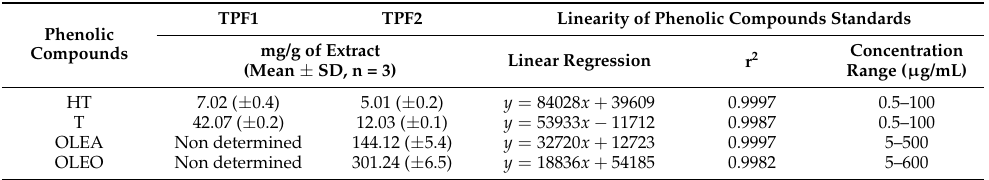
Figure 1. HPLC-DAD chromatograms obtained from the analysis of TPF1 ( A ) and TPF2 ( B ) ex- tracts, applying the IOC proposed method. Hydroxytyrosol (HT), tyrosol (T), oleacein (OLEA), and oleocanthal (OLEO) peaks are indicated. Table 1. Phenolic composition of the analyzed TPF1 and TPF2 extracts. Data of the regression model (linear regression, r-squared and concentration ranges) are